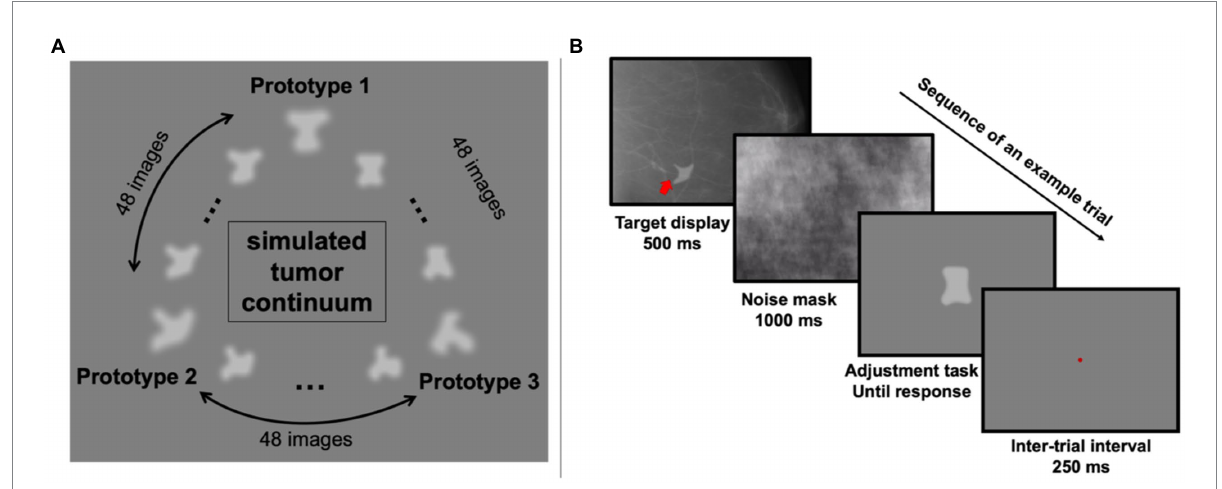
FIGURE 1 Stimuli and an example trial in Experiment 1. (A) The simulated tumor continuum was generated from three tumor-shape prototypes. Between each pair of prototype images, 48 morph images were generated, resulting in a total of 147 images. (B) On each trial, observers saw a simulated tumor target (indicated by the red arrow; note that the red arrow was never shown in actual experiment) superimposed on a real radiograph for 500 ms, which was followed by a noise mask covering the full screen for 1,000 ms. Then a randomly chosen simulated tumor was shown at the center of the screen and observers pressed the left or right arrow key to adjust it and match it with the target. They confirmed their response by hitting the space bar and after a 250-ms inter-trial-interval, the next trial